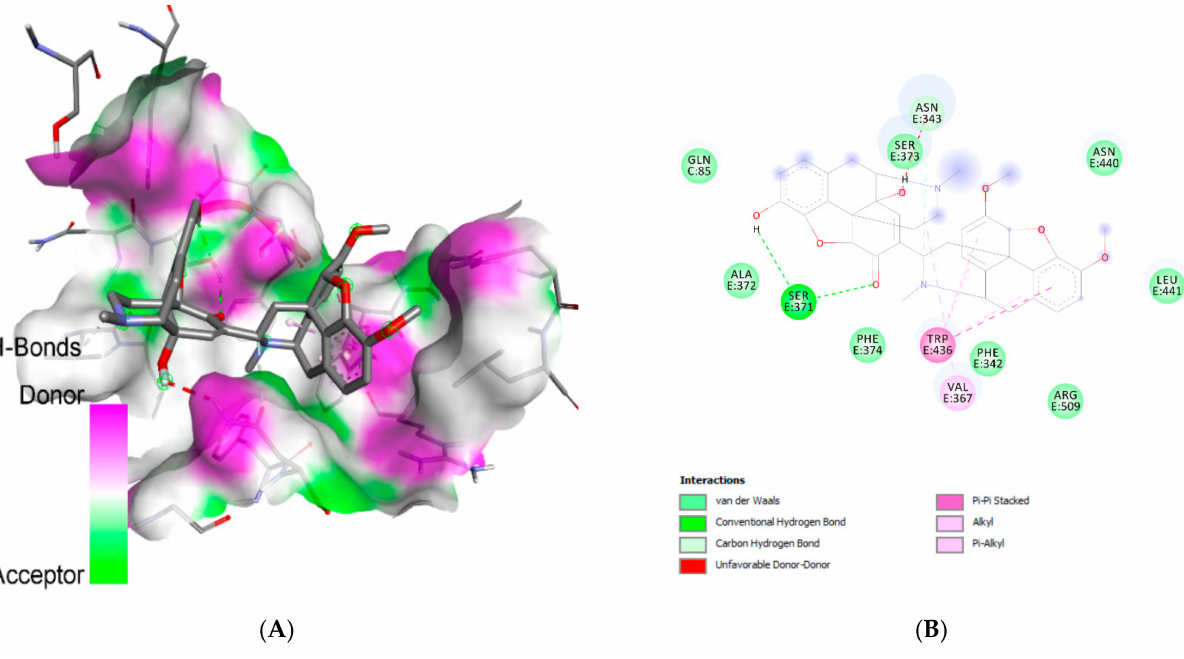
Figure 2. Three-dimensional ( A ) and two-dimensional ( B ) diagrams depicting the interaction of somniferine with the amino acid residues of the receptor-binding domain